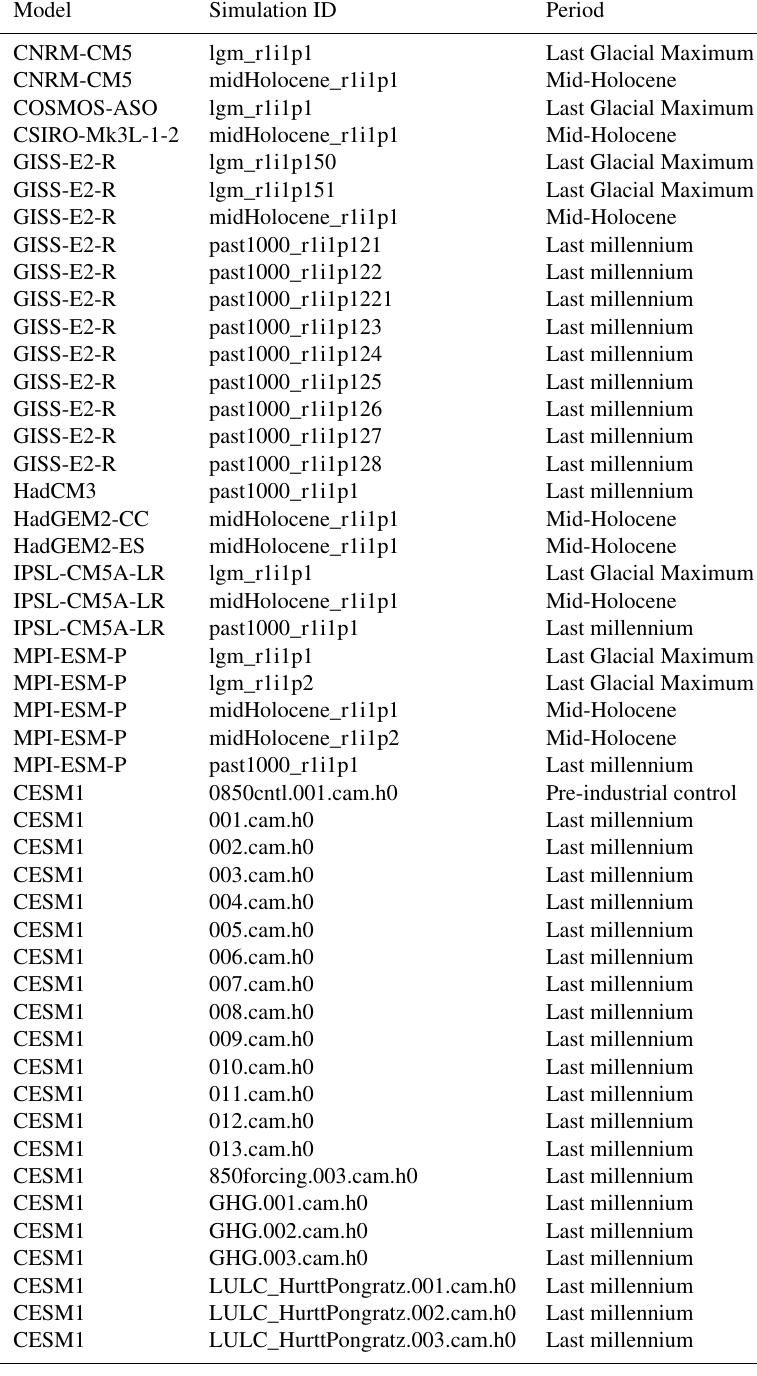
Table A3 complements Tables 2 and A2. They give the simulation IDs that allow finding the simulations more easily in the repositories. Table A3. Information on individual simulations: model, simulation, and